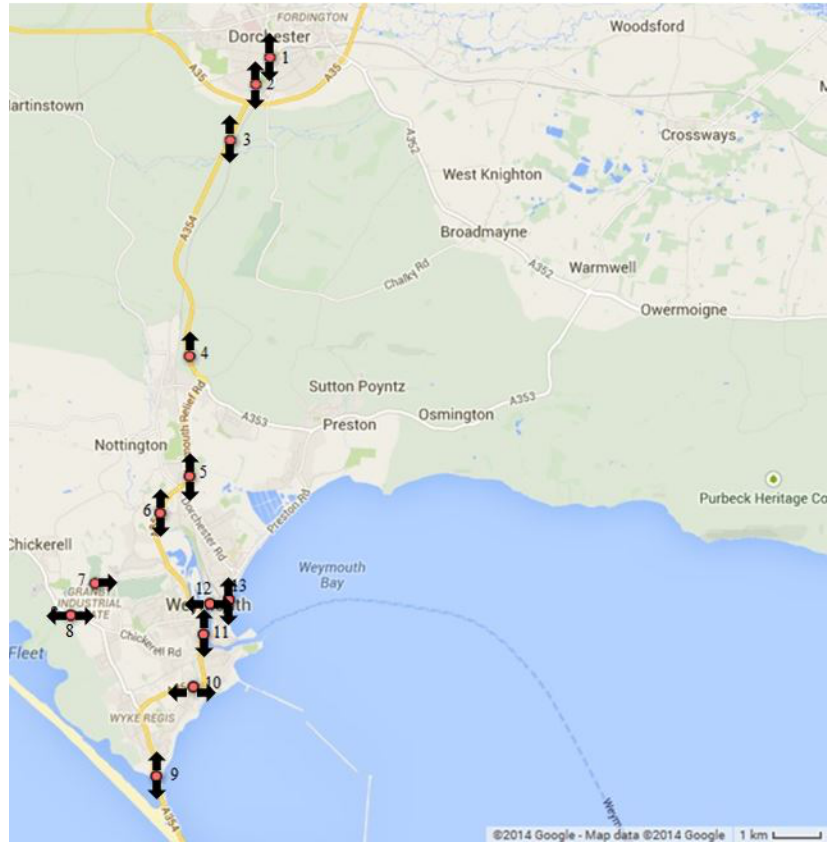
Figure 1. ANPR sites and directions of travel